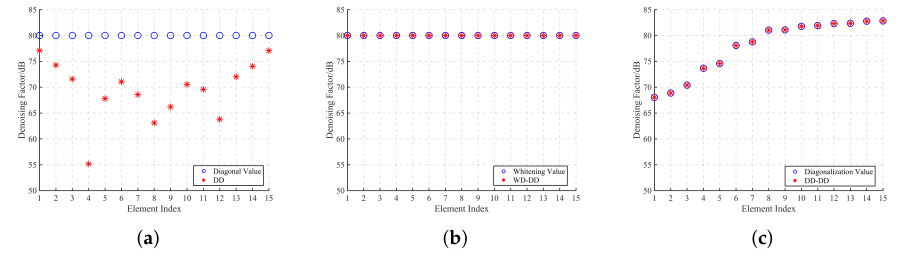
Figure 4. The diagonal elements and the calculated denoising factors for ( a ) the received noise CSM, ( b ) the whitened CSM, and ( c ) the diagonalized CSM under the ideal condition.